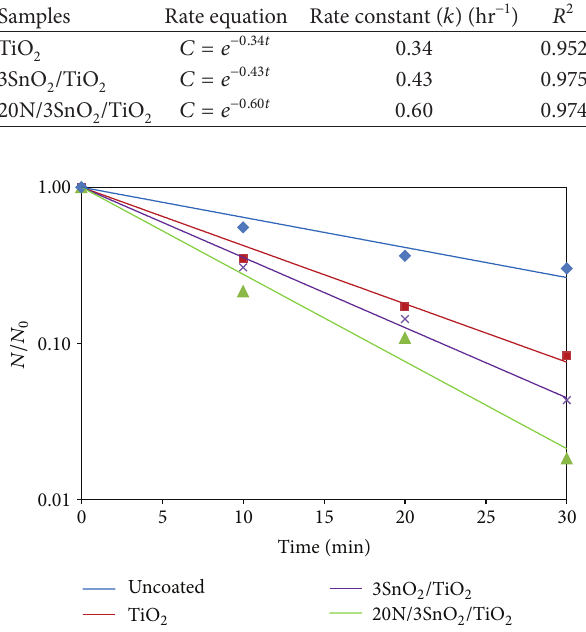
Figure 11: Antibacterial effects of glass fibers with various coatings against E. coli under UV